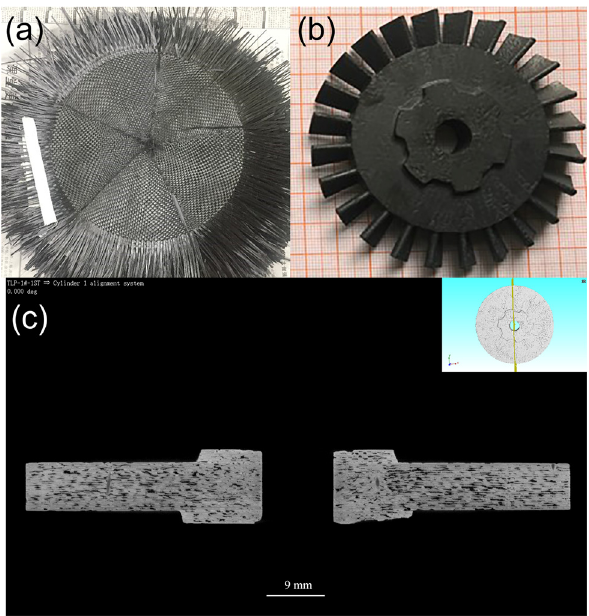
Figure 2: ( a ) SWS fi ber ’ s preform; ( b ) SWS - SiC/SiC turbine blisk; and ( c ) micro - CT scan photo of SWS - SiC/SiC turbine